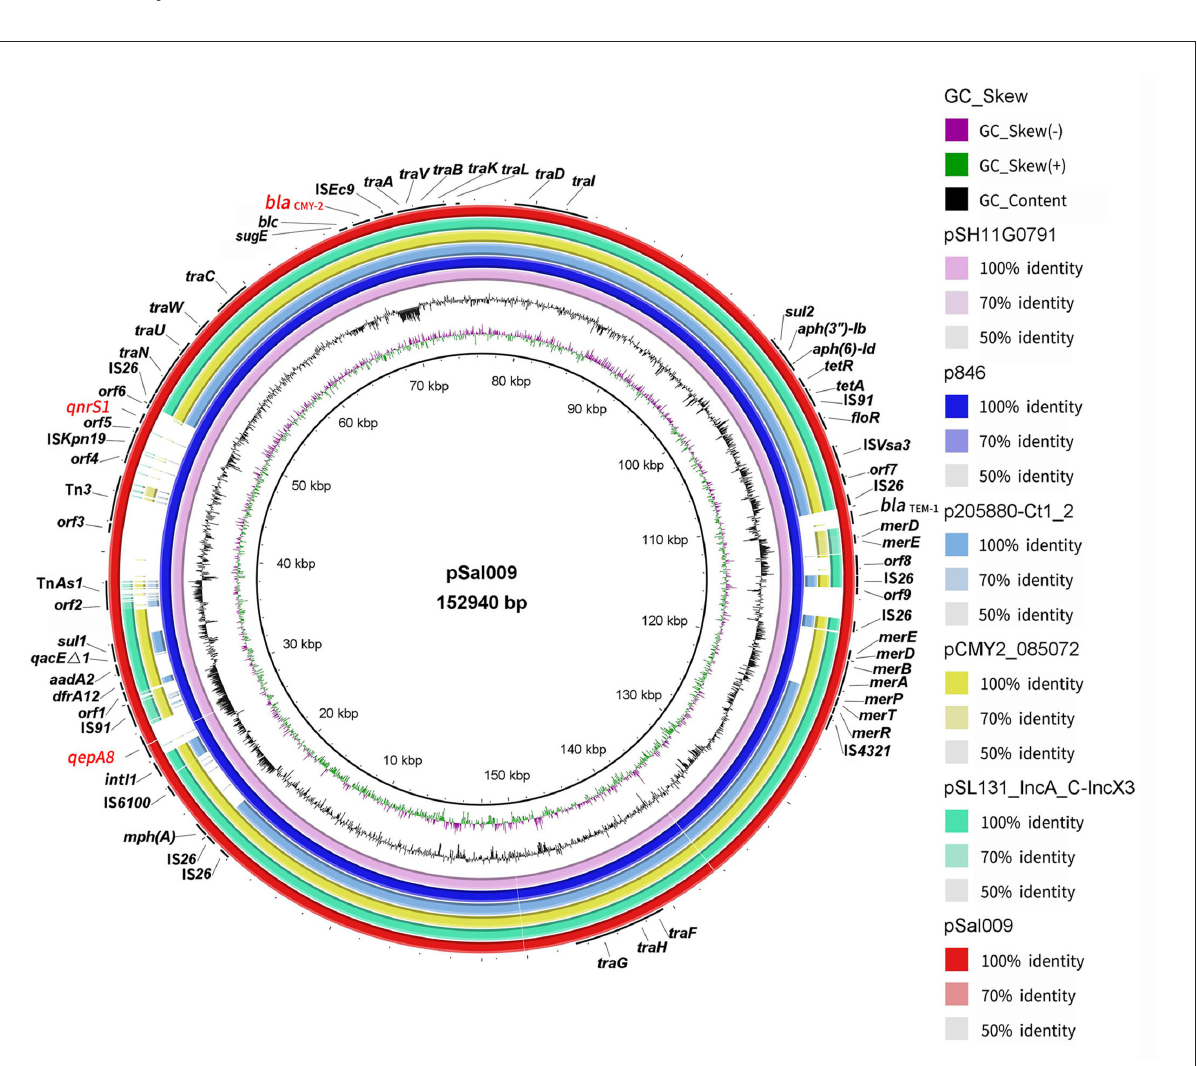
FIGURE1 Sequence comparison of plasmid pSal009 identified in S. Thompson 17Sal009 with closely related plasmid pSH11G0791 and p846 as well as similar plasmids (p205880-Ct1/2, pCMY2_085072, and pSL131_IncA/C-IncX3) sharing similar backbone in different bacteria species in BRIG. GC content and GC skew of pSal009 are depicted in the inner rings. The genes located on pSal009 are annotated at the outside black ring. The bla CMY − 2 , qnrS1 , and qepA8 genes are marked